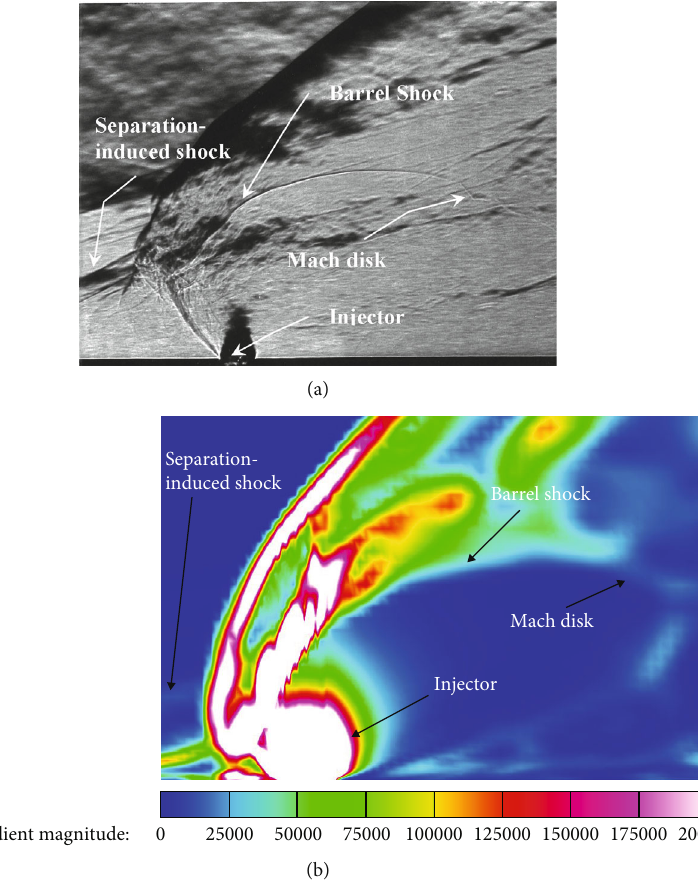
Figure 7: Experimental schlieren photograph and CFD solutions on the symmetry plane: (a) experimental schlieren photograph [42]; (b) CFD density gradient calculated via LES.